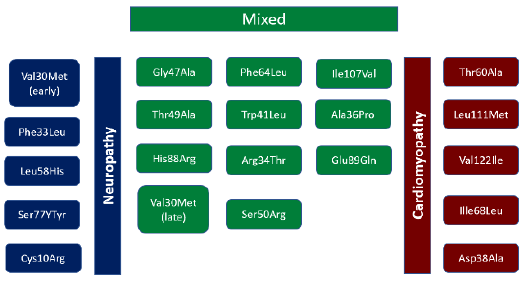
Figure 6. Spectrum of TTR mutations and their phenotypic features. Adapted from Semigran M., J. [22].